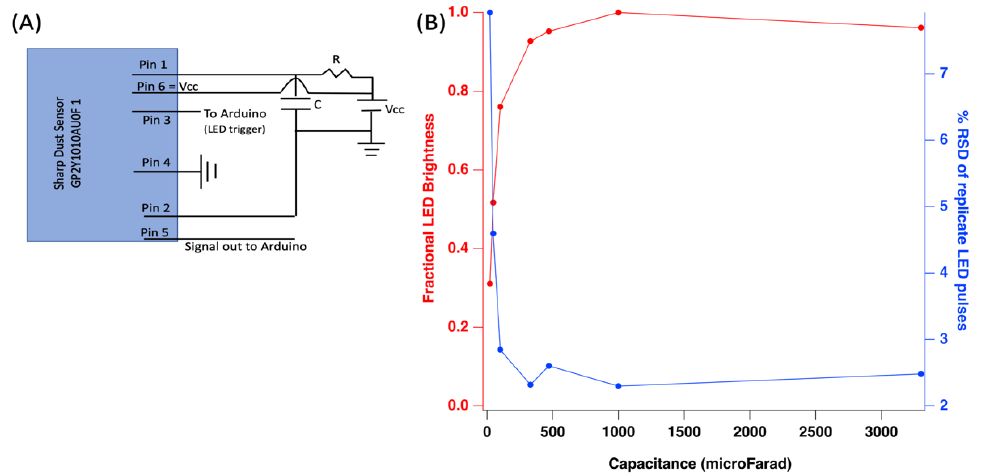
Figure 2. ( A ) External circuit and connections required to operate the Sharp dust sensor. In this study, values for both R and C were varied to optimize performance. ( B ) Effect of capacitor value on indicated LED brightness and pulse-to-pulse variability as measured by the percent relative standard deviation (% RSD) of replicate pulses. Dust sensor #1 was used.